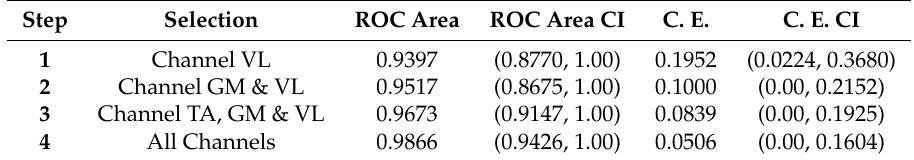
Table 3. Results of Channel forward selection of variables based on the area of ROC curve